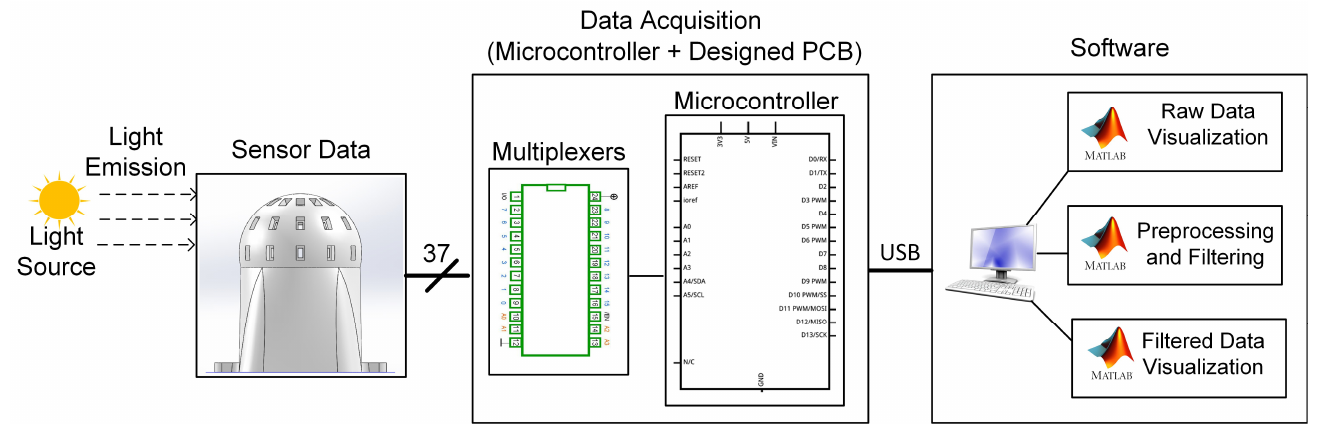
Figure 2. Overview of The Measurement